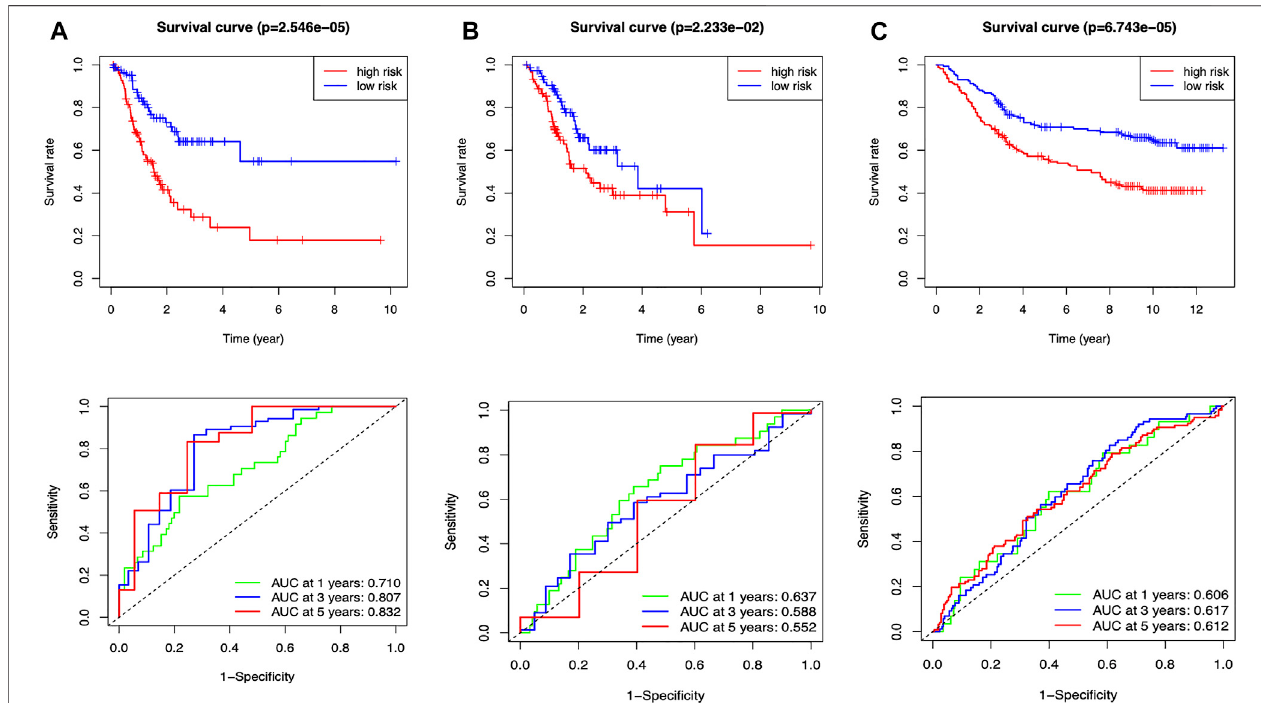
FIGURE 4 | Clinical prognostic model evaluation (A) Training group (B) Internal validation group (C) External validation group, GSE84433_series_matrix.